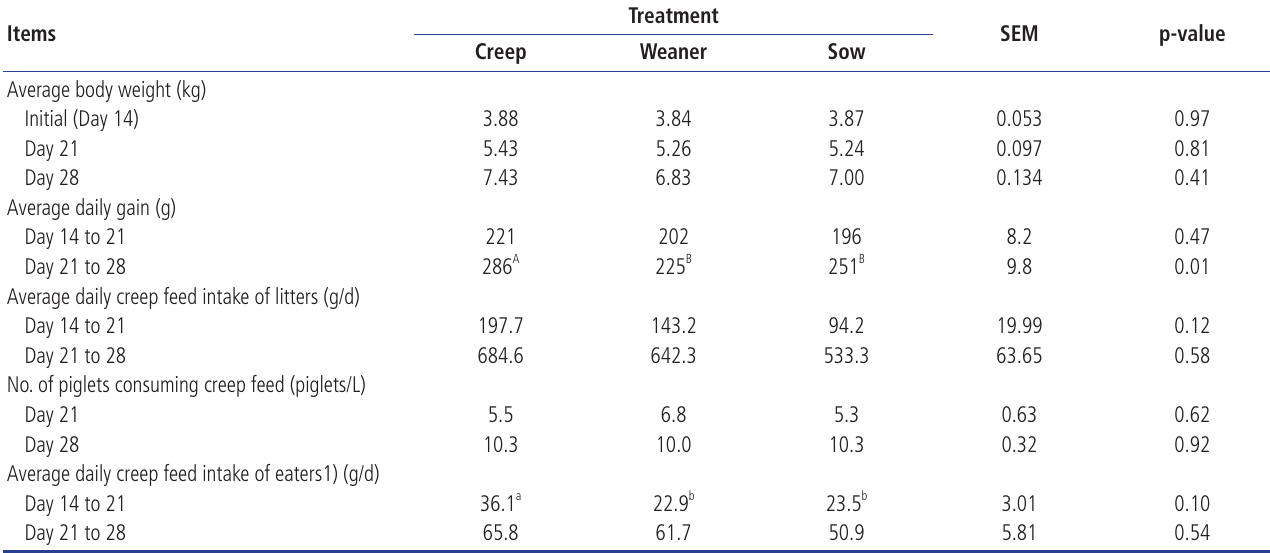
Table 3. Effect of different creep feed types on piglet growth and creep feed intake Items